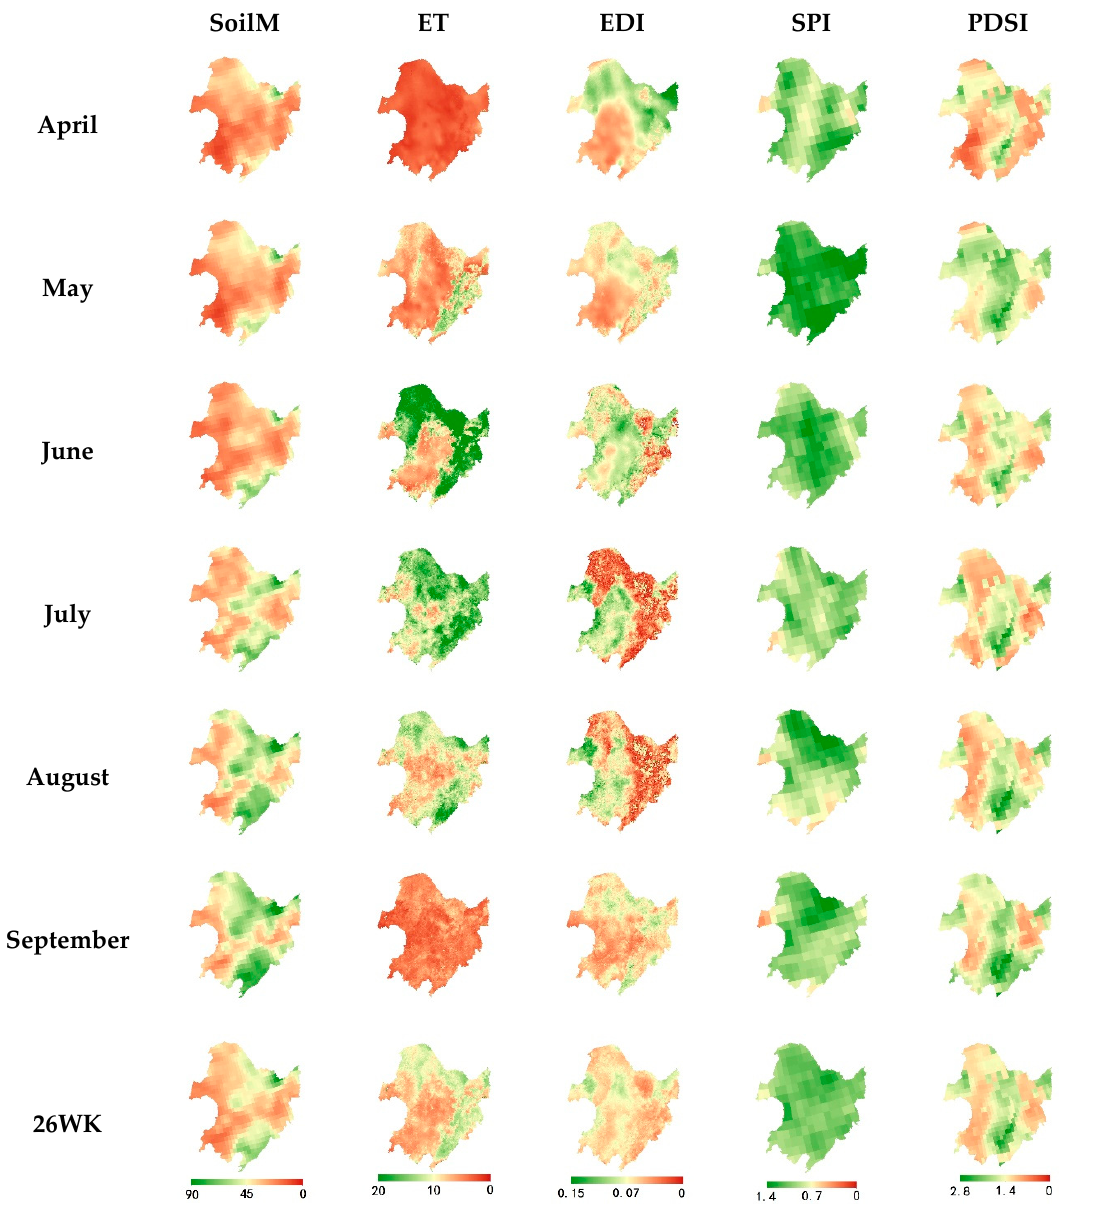
Figure 4. Monthly and seasonally composited (26-week) maps of the temporal standard deviation. Red indicates lower variability.